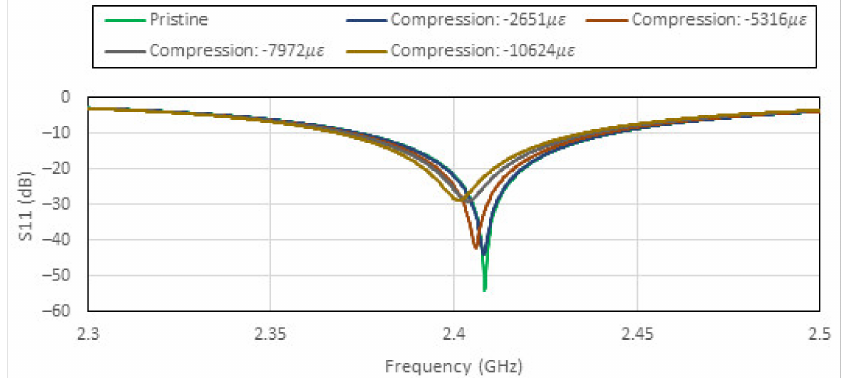
Figure 9. Effects of compressive loading on the patch antenna’s S11 plotted against frequency.